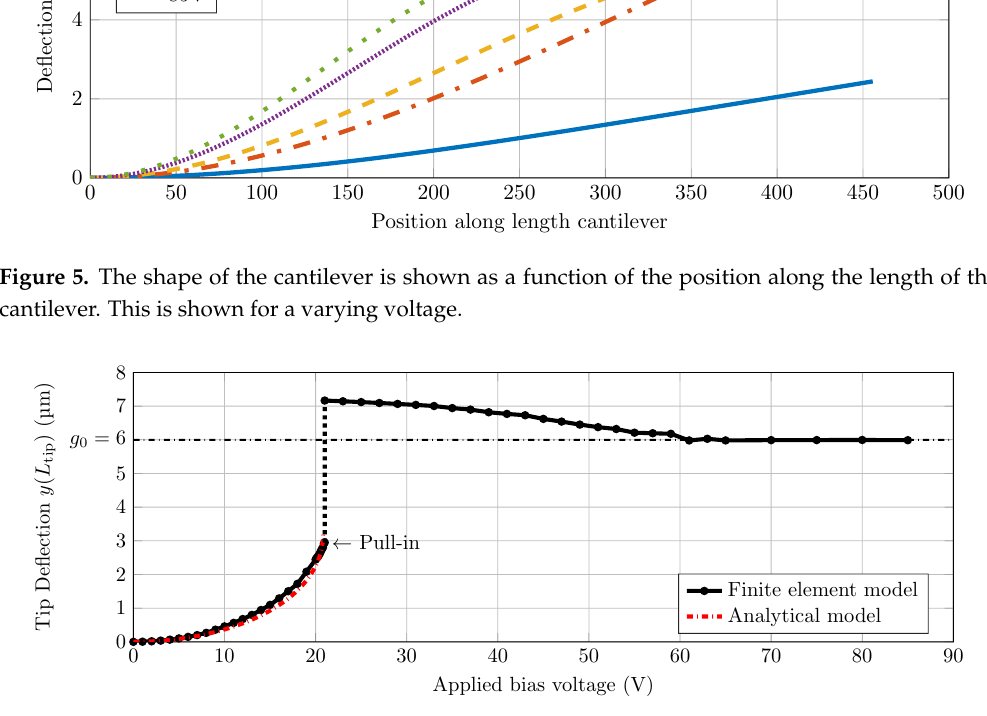
Figure 6. Modeling results. Tip deflection as a function of applied voltage. Up to pull-in the system is simulated as a stationary system. The analytical model shows similar results. After pull-in it is simulated as a time-depended study and the deflection at steady state is shown.